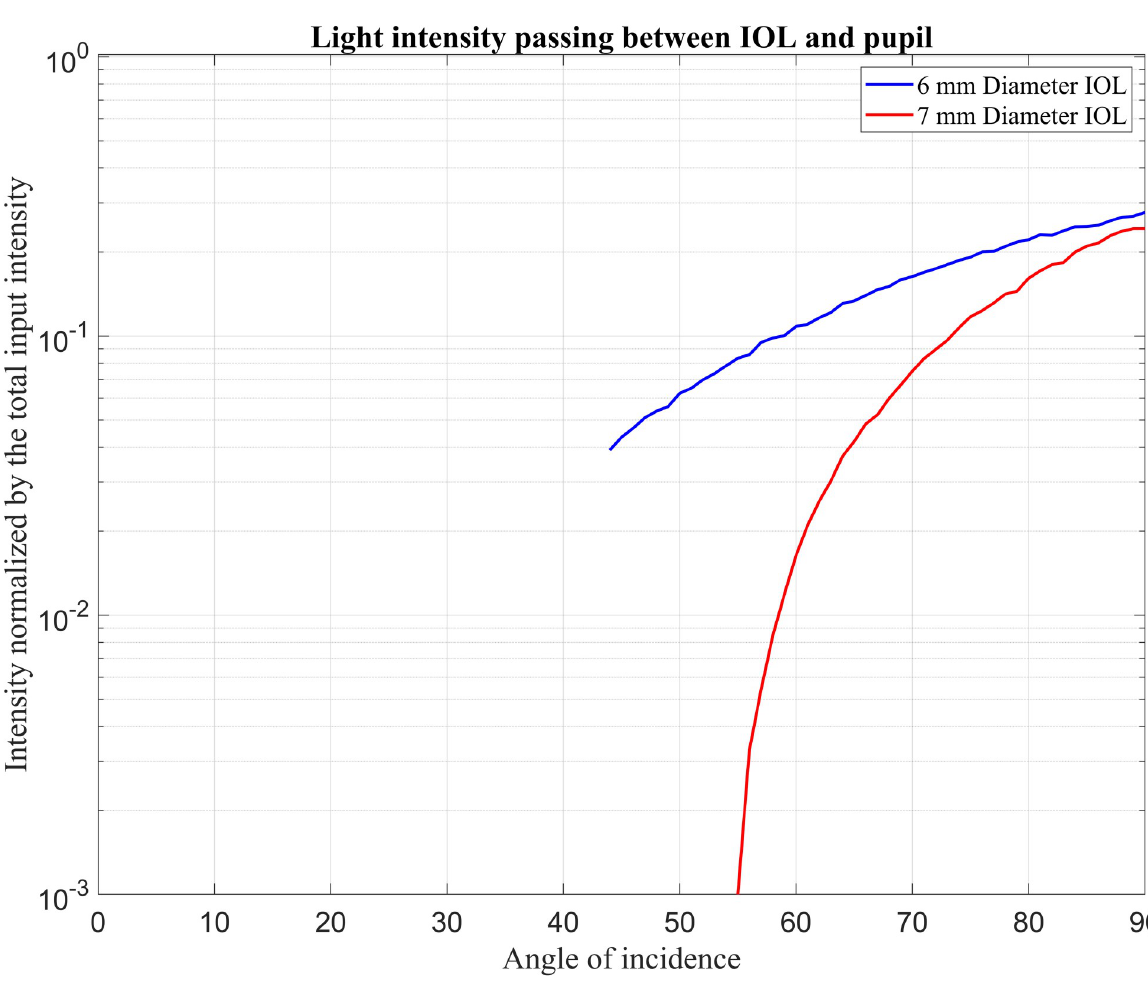
Fig 3. Normalised input intensity detected by the Detector-N over the incident ray angle.